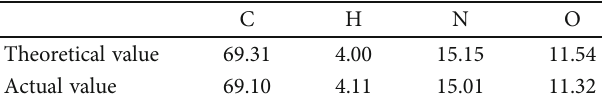
Table 4: Elemental composition of 6-(2,2 ′ :6 ′ ,2 ″ -terpyridine-4 ′ -formamide) hexanoic